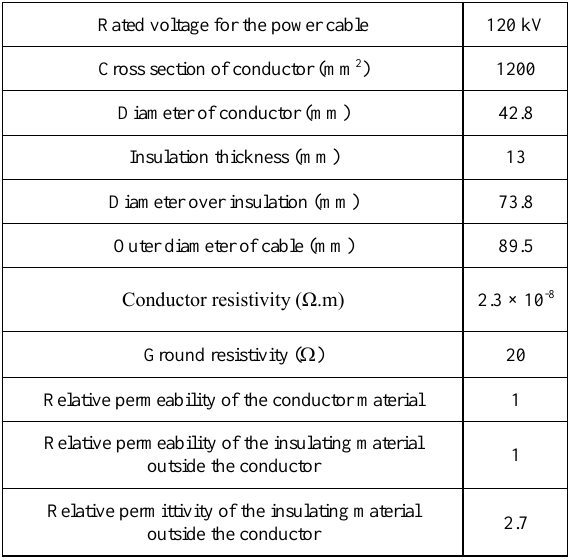
Fig. 35. Hysteresis characteristics for transformer core. TABLE 2: P OWER CABLES